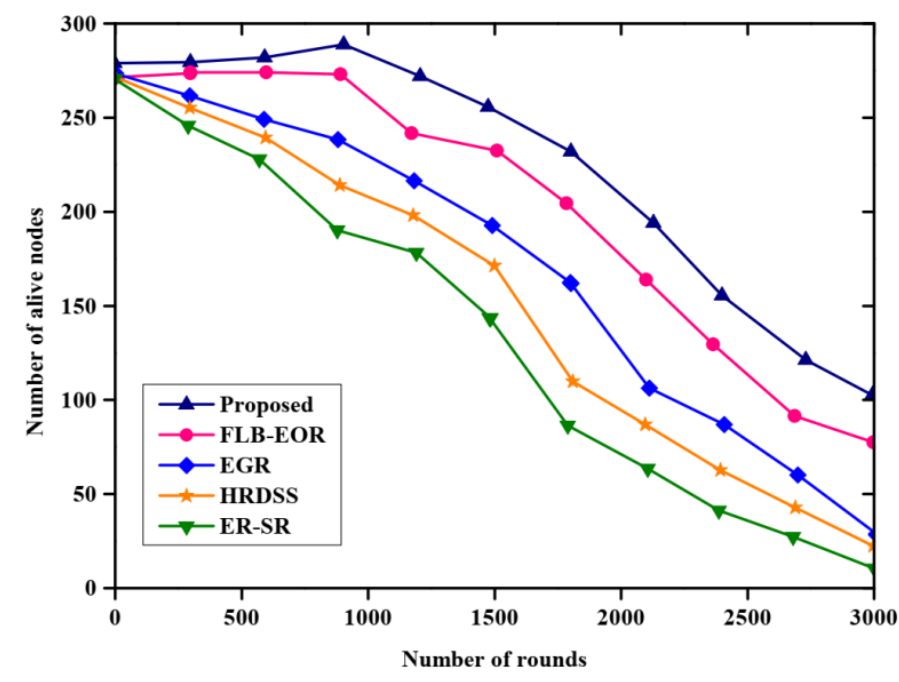
Figure 4. Comparative analysis of network lifetime.